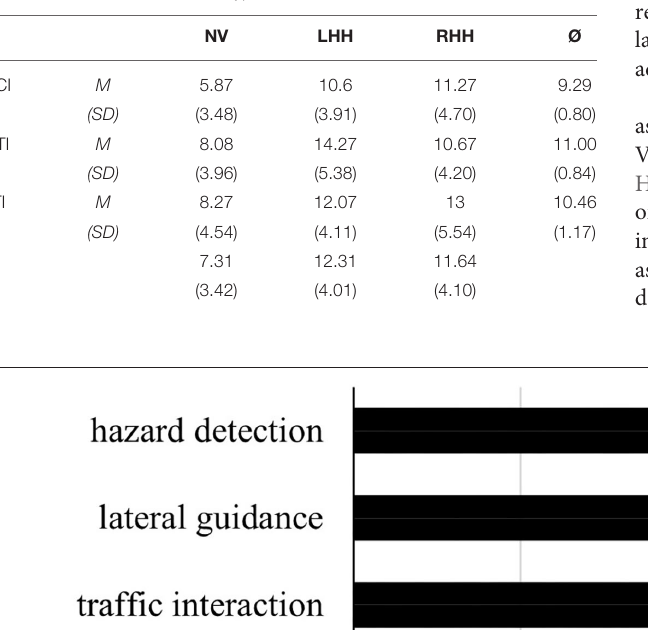
Frontiers in Neuroergonomics |